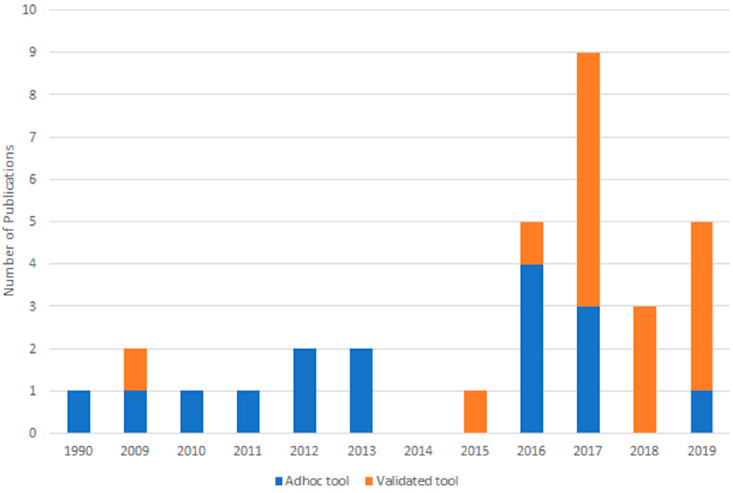
Figure 2. Publications with ad-hoc versus validated tools over time.